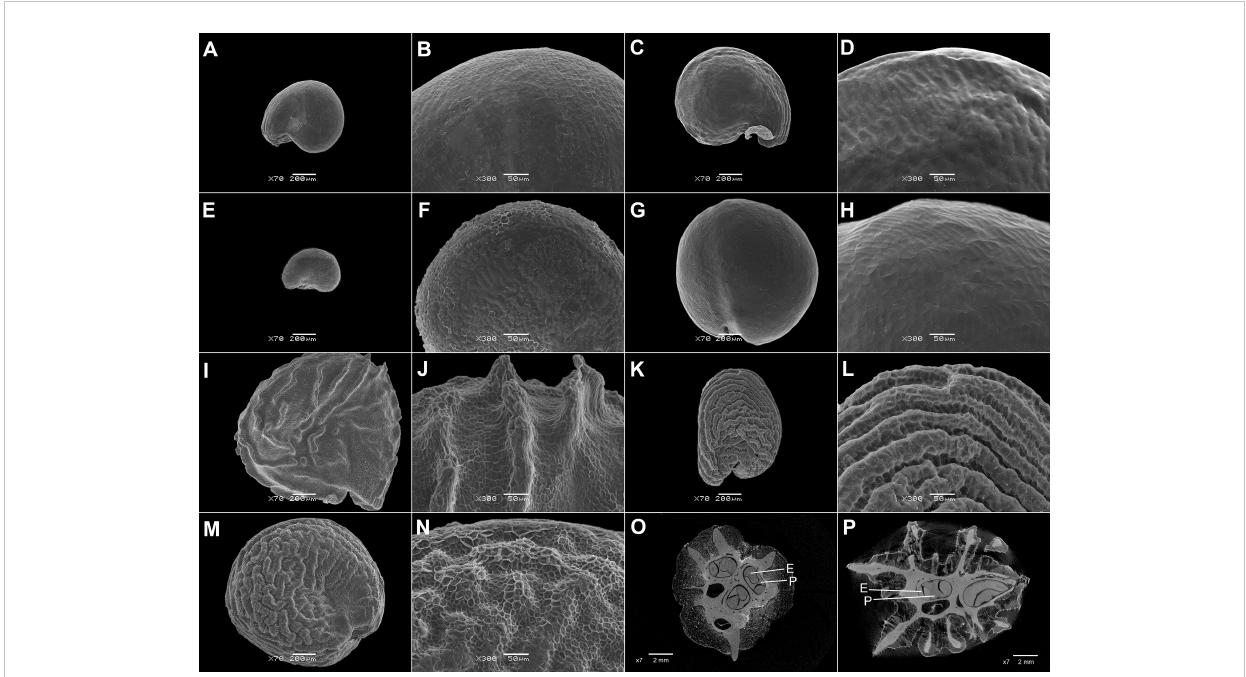
FIGURE 2 SEM micrographs or tomograms of selected Sesuvioideae species. (A, B) A seed of Sesuvium maritimum (covered with an aril), (C, D) a seed of Sesuvium curassavicum , (E, F) a seed of Sesuvium mezianum (covered with an aril), (G, H) a seed of Trianthema hereroense , (I, J) a seed of Trianthema portulacastrum (covered with an aril), (K, L) a seed of Trianthema crystallinum (covered with an aril), (M, N) a seed of Zaleya pentandra (covered with an aril), (O) a tomogram of a Tribulocarpus somalensis fruit with three visible seeds, and (P) a tomogram of a Tribulocarpus dimorphanthus fruit with two visible seeds. Magni fi cation: (A, C, E, G, I, K, M) 70×; (B, D, F, H, J, L, N) 300×; (O, P) 7×. P, perisperm; E,